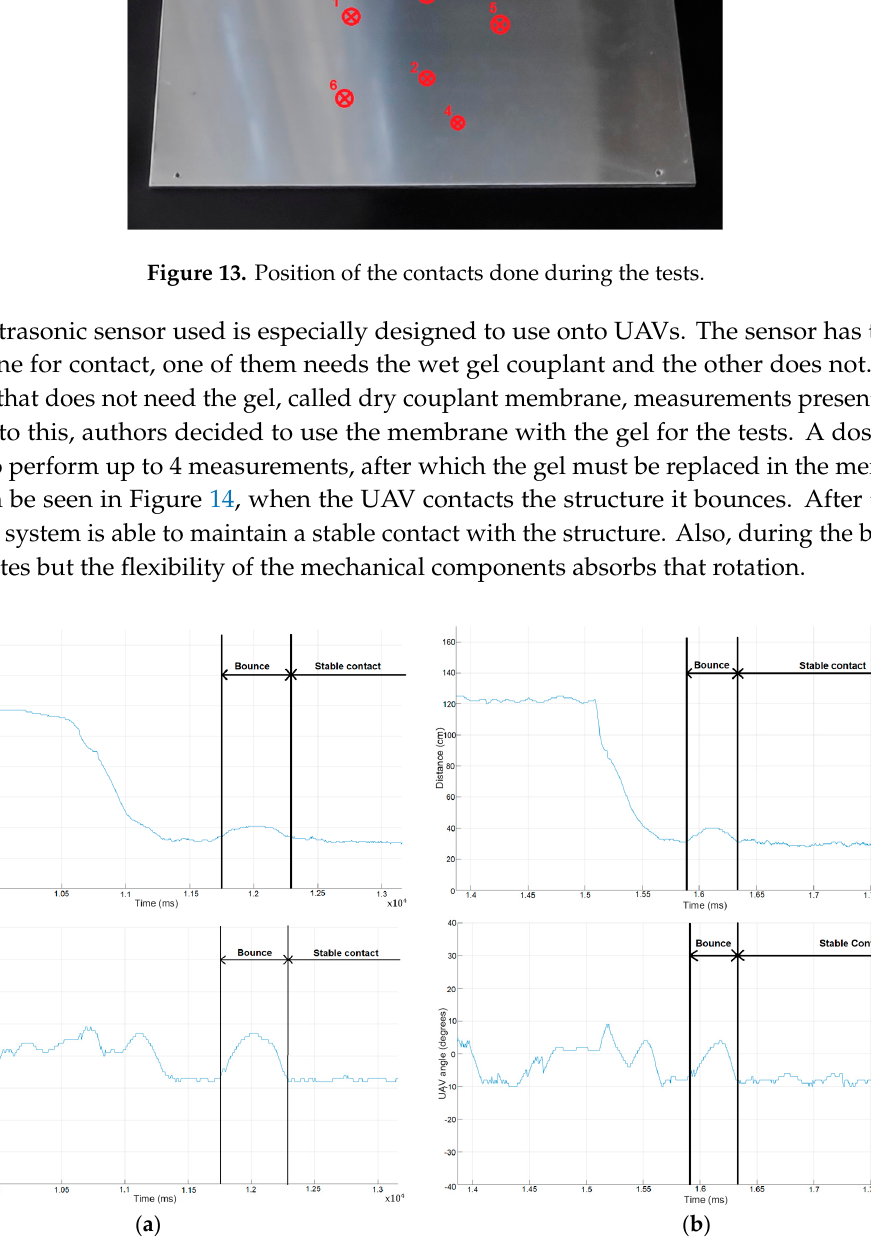
Figure 14. Angle and distance of the UAV regarding the structure during the approaching and the contact. ( a ) First contact. ( b ) Second contact.